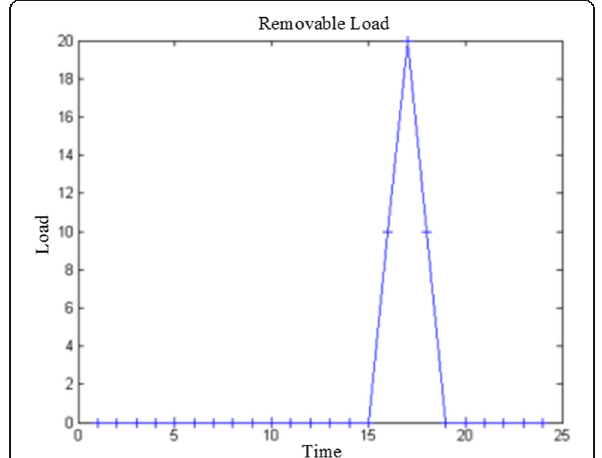
Fig. 11 The Profile of original removable load